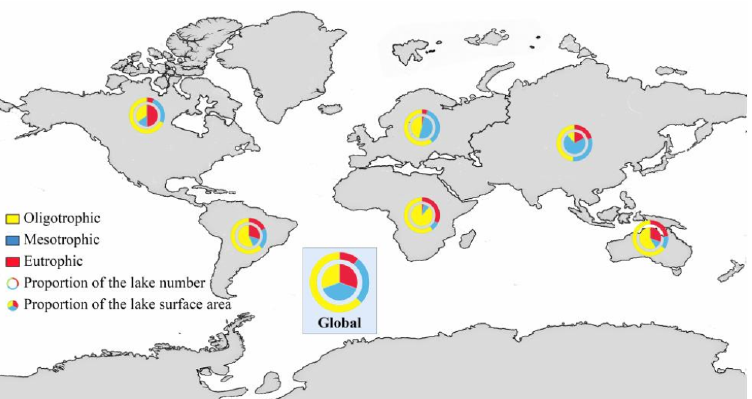
Figure 2. Global distribution of water eutrophication. The pie chart of the outside circle corresponds to the proportion of the number of large lakes in each eutrophication state in the continent, and the pie chart of the inside circle corresponds to the proportion of the surface area of large lakes in each eutrophication state in the continent (Africa, Asia, South America, North America, Oceania and Europe). Global data for the six continents of the world (except Antarctica) in 2018